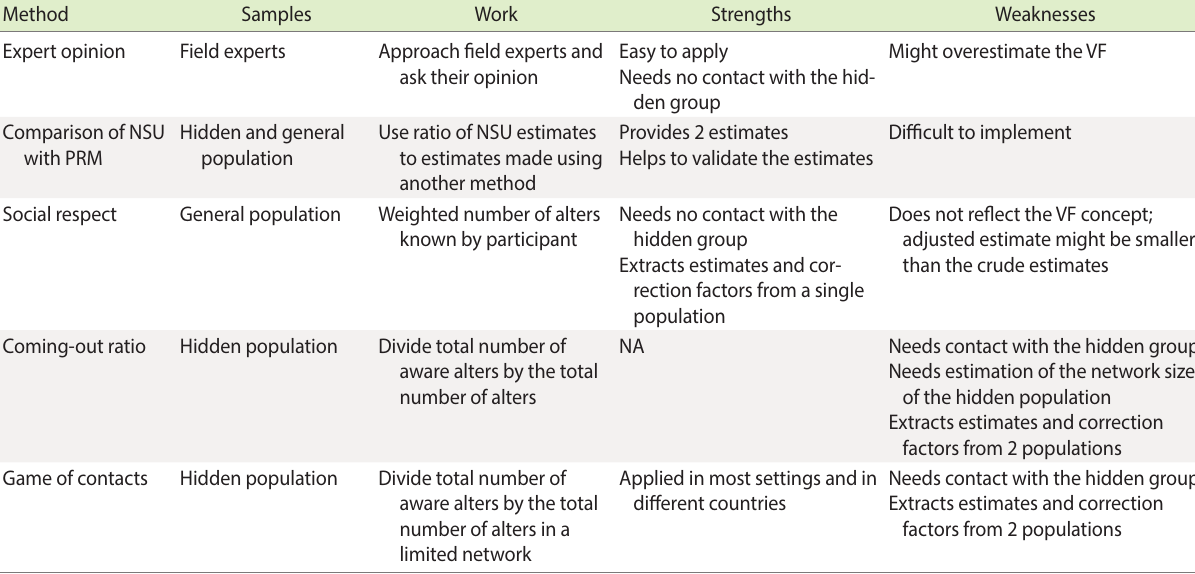
Table 1. Summary of methods used to estimate the